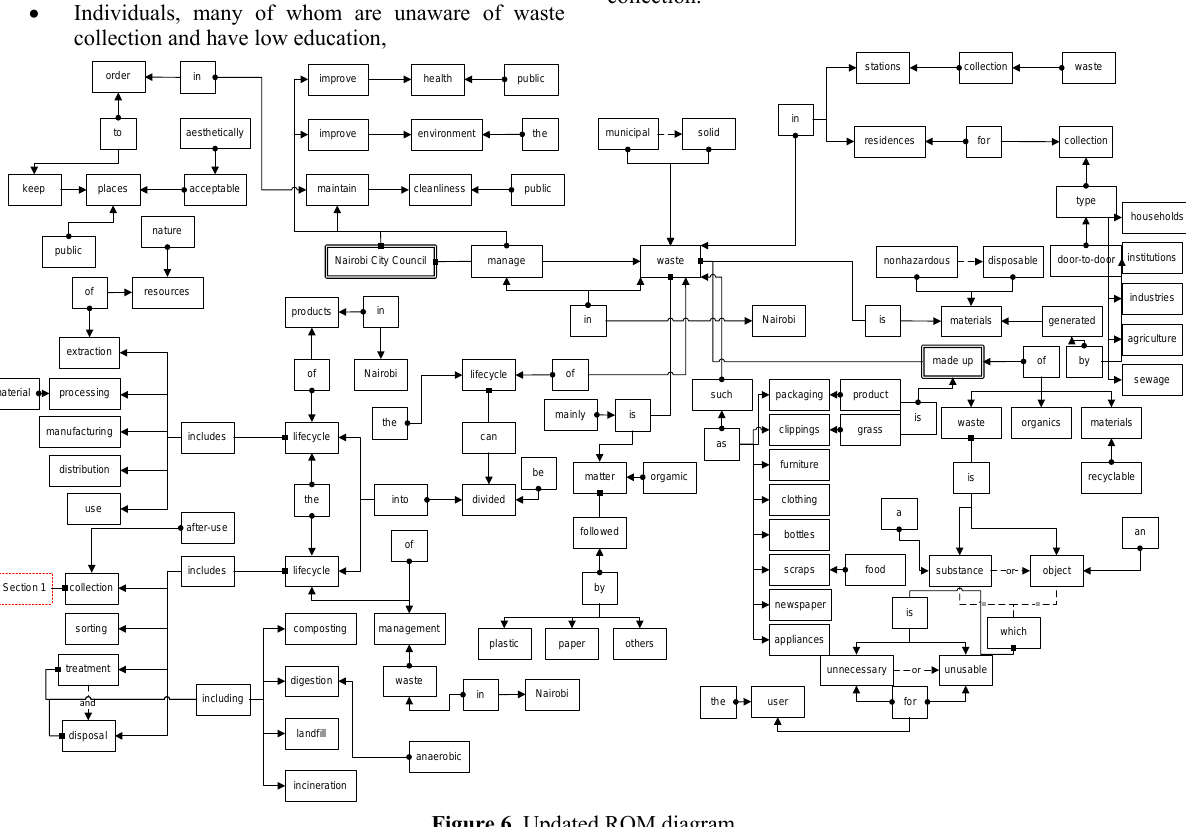
Figure 6 . Updated ROM